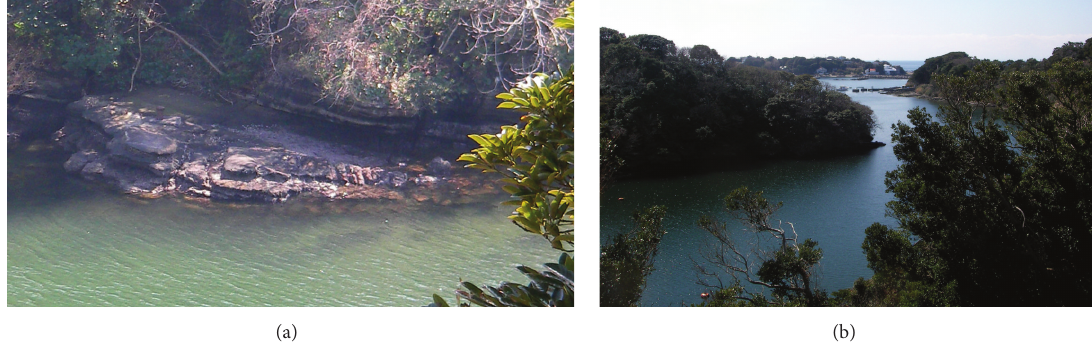
Figure 2: Habitat of H. septentrionalis . This species is found along rocky shores with overhanging vegetation nearby (a), in a calm inner bay protected from strong winds and waves